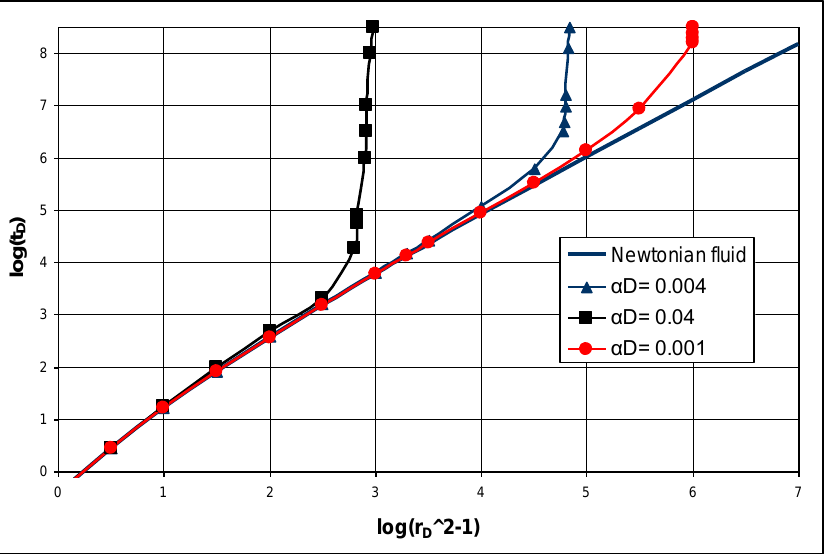
Figure A.1. The effect of yield point of the mud system on the invasion model